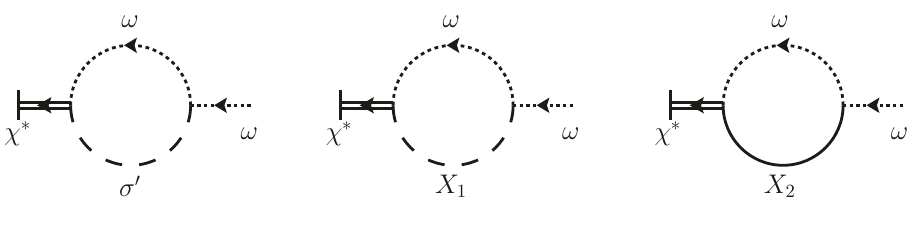
Figure 2 . Diagrams contributing to the UV divergent 1-PI amplitude Γ (1)